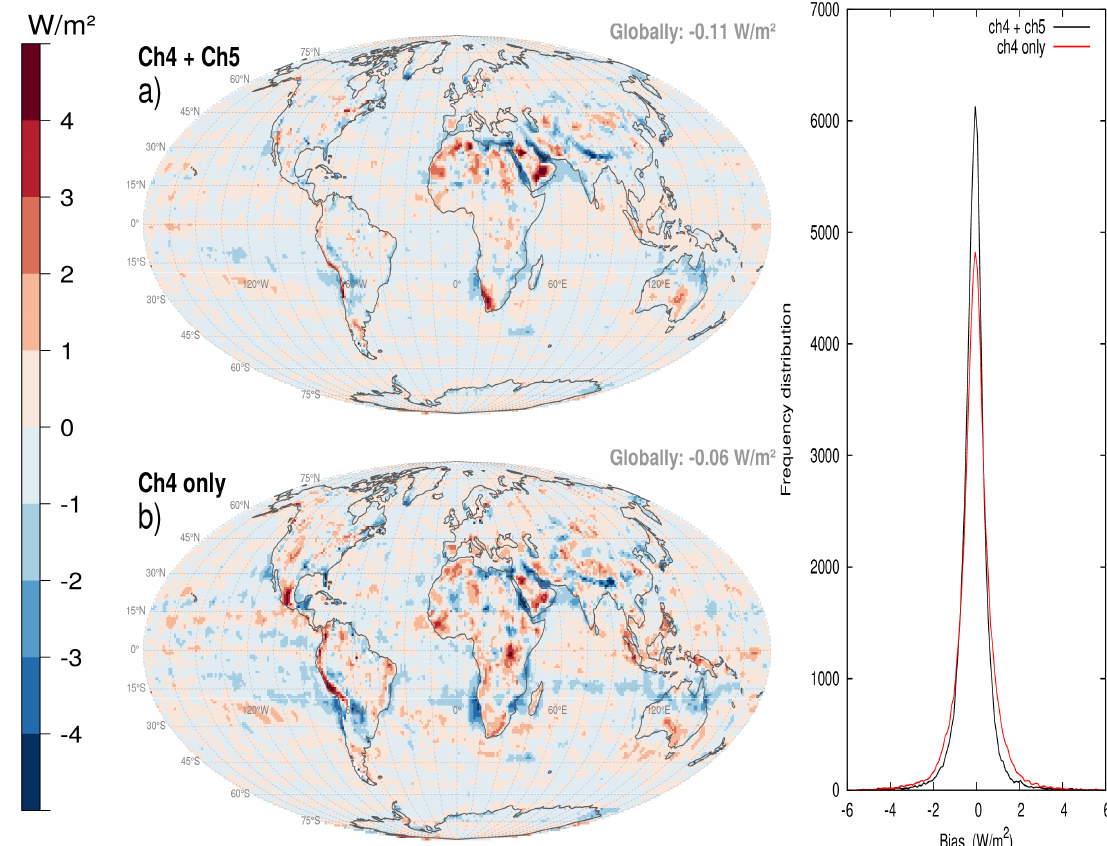
Figure 3. Regional variation of the bias (Wm − 2 ) in 1 ◦ × 1 ◦ latitude-longitude boxes. ( a ) is for the two channel regression (Equation (1)) and ( b ) when Channel 5 is not available (Equation (2)). The histograms are also given (right).